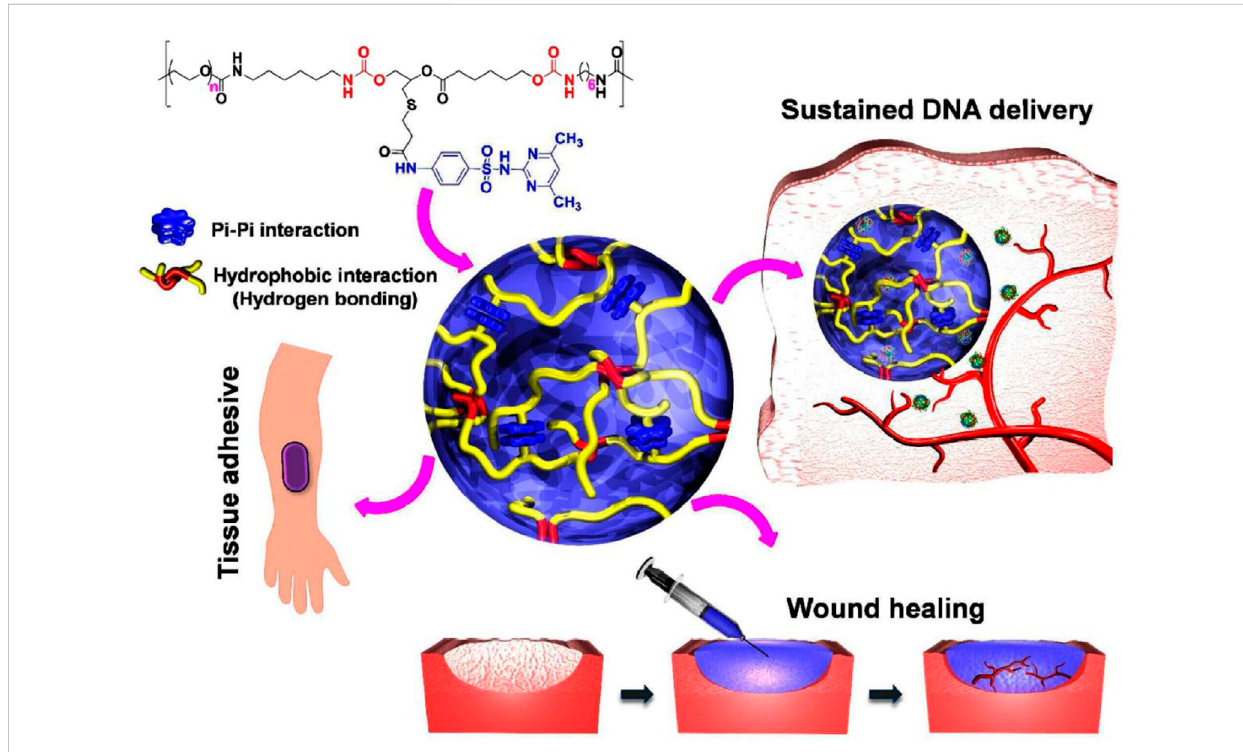
FIGURE 1 Theidea ofPEG-PSMEU copolymers ’ sol-to-gel phasetransitionandtheirnumerous biomedical applications.i)Followingsubcutaneous deliveryof PEG-PSMEUcopolymersolscontainingpolyplex,aviscoelasticgelwascreatedthatcontrolledthereleaseofthepolyplex.ii)Similartoadhesivesinspired by mussels, the PEG-PSMEU copolymer hydrogel easily penetrates onto the skin ’ s surface. iii) The hydrogels ’ tissue adhesion properties are used in woundhealingtoclosewoundsandrestoretissuestructureandfunction.Reprintedwithpermissionfrom(Leetal.,2018).Copyright2018American Chemical Society.